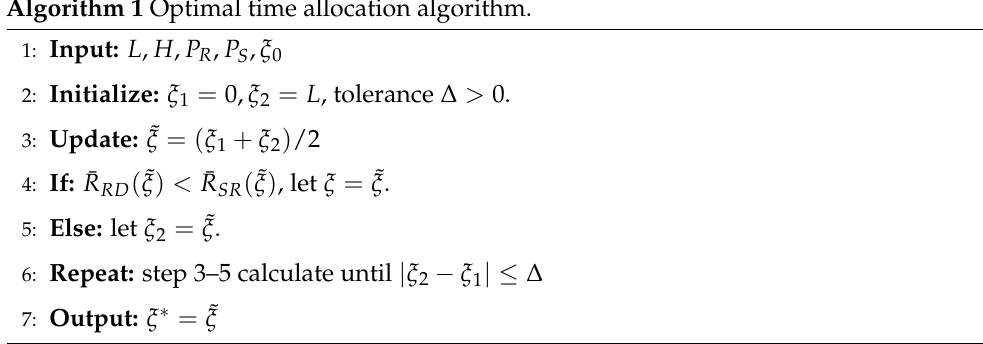
Algorithm 1 Optimal time allocation